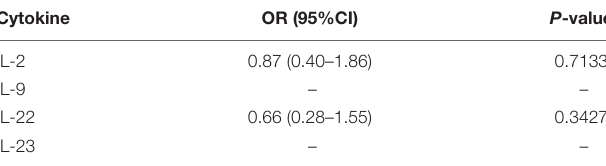
TABLE 7 | Effects of MedDiet on plasma levels of regulatory cytokines.